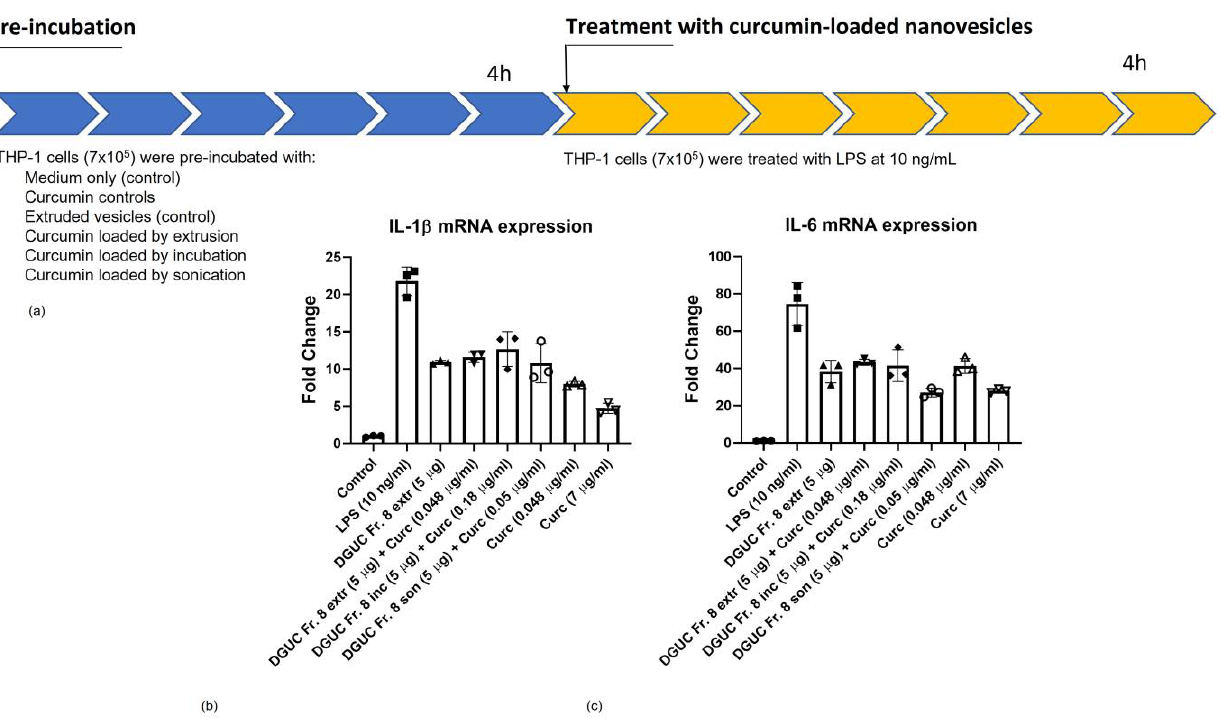
Figure 8. Anti-inflammatory effect of curcumin loaded tomato-derived vesicles. ( a ) Pre-incubation and treatment conditions. Three different methods were used for loading according to Figure 6 and Table 2. As a control, curcumin was used at two different concentrations. Density gradient Fraction 8 was extruded (DGUC Fr. 8 extr., control) or loaded by direct incubation followed by DGUC purification (DGUC Fr. 8 Inc.), sonication (DGUC Fr. 8 son.) and anti-inflammatory effect was evaluated on THP-1 cell line measuring the levels of pro-inflammatory cytokines ( b ) IL-1 β ; ( c ) IL-6. All the tested conditions were significantly down-regulated compared with LPS (10 ng/mL) condition (ANOVA test followed by Dunnett’s post-hoc analysis; p ≤